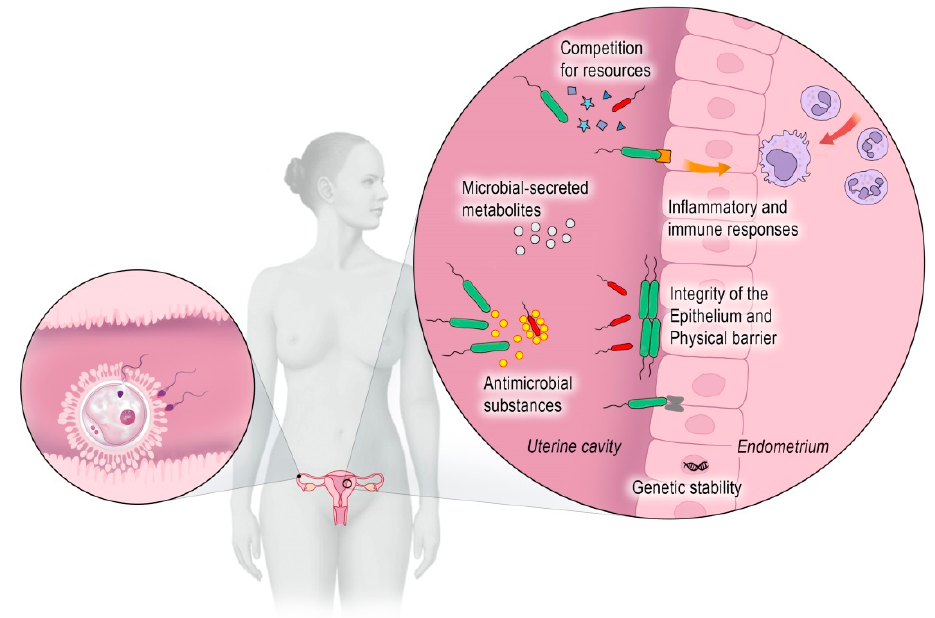
Figure 1. The oocyte, spermatozoa, and the maternal environment are responsible for a successful implantation.